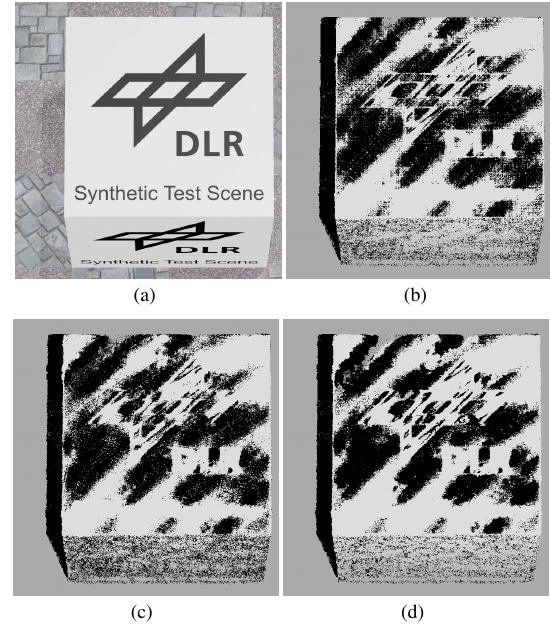
Figure 9. SGM on a low-texture cube (a) RGB image, (b) height image for 8 directions, (c) 8 directions offset by 11 ◦ , (d) 256 directions sampled version of the stereo pair of 2048 by 1536 pixels (3.15 megapixels). Two versions of SGM with and without NEON SIMD intrinsics have been executed using four threads. Table 4 shows the overall runtime in seconds including image I/O.